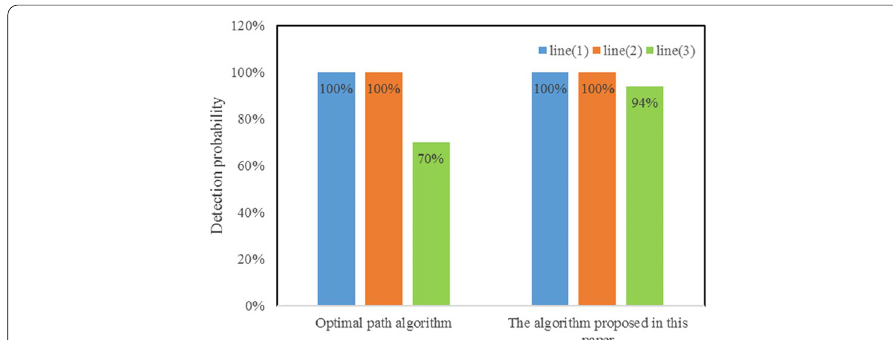
Fig. 9 P D of different line spectra using two methods studied at